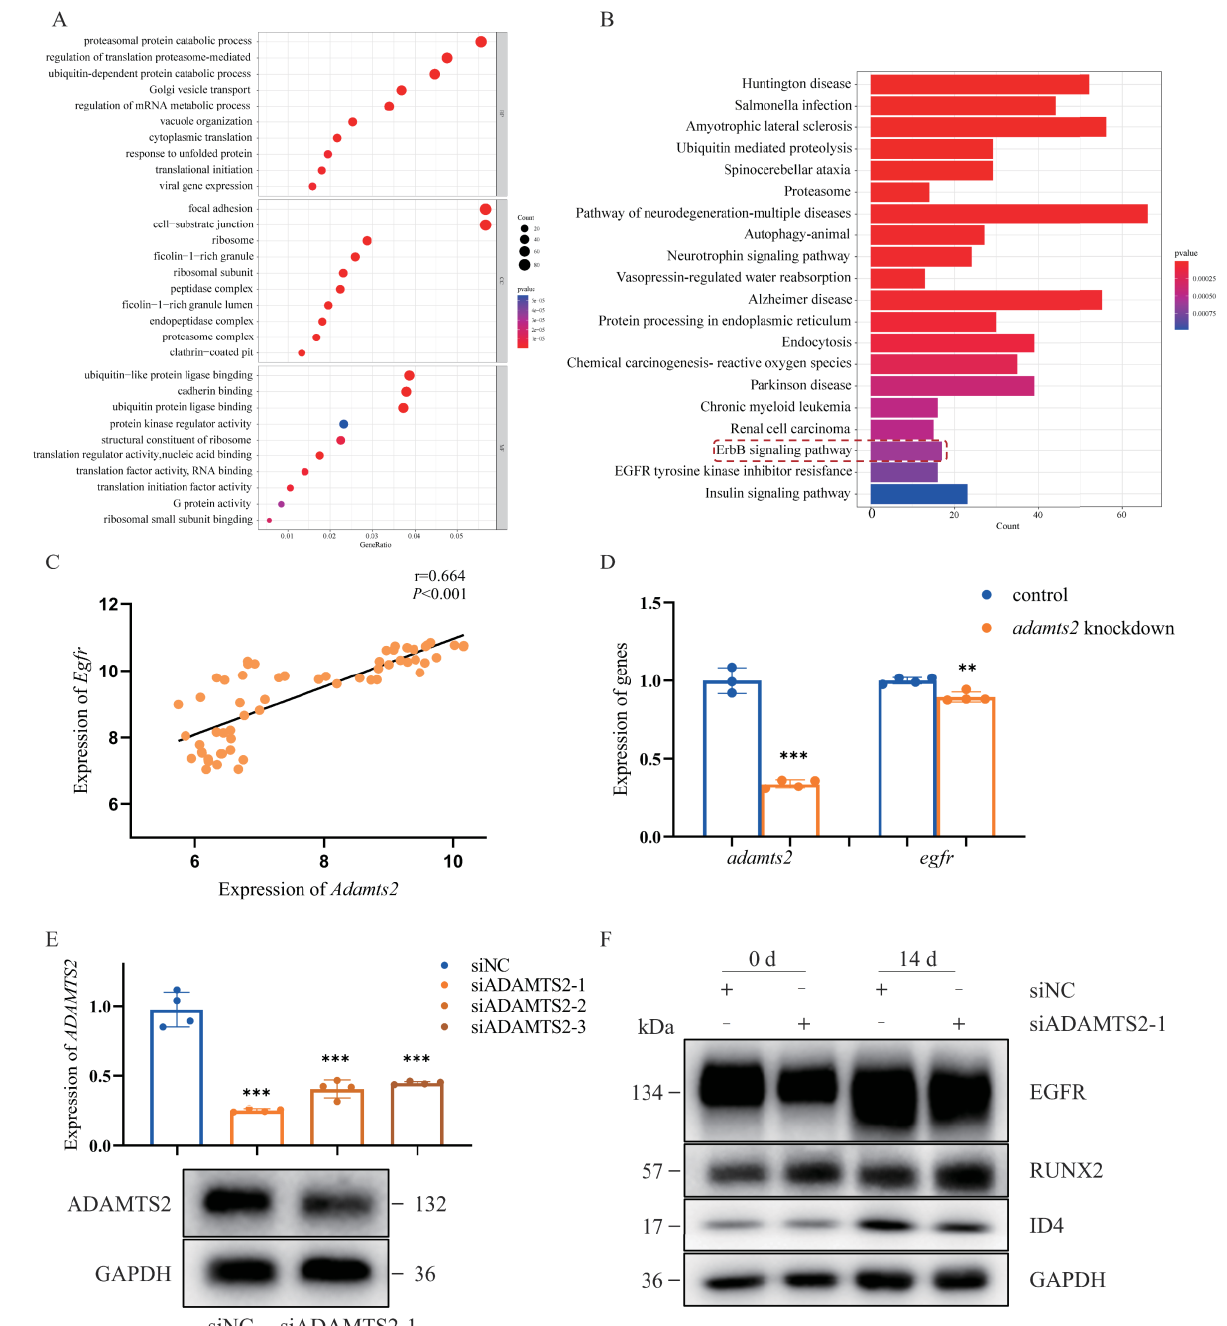
Figure 4. ADAMTS2 was involved in several important pathological pathways based on gene ontology (GO) and Kyoto Encyclopedia of Genes and Genomes (KEGG) enrichment analysis. ( A ) The top 10 GO terms by gene ratio in the biological process terms and cellular component terms and molecular function terms in the enrichment analysis. ( B ) The top 20 most significantly enriched pathways by p -value with the genes co-expressed with ADAMTS2 in the KEGG analysis. ( C ) Egfr was co-expressed with Adamts2 during mouse embryonic development of upper and lower jaw (E10.5–E14.5). ( D ) qRT-PCR analysis of the expression of egfr in the adamts2 -knockdown zebrafish embryos at 72 hpf. ( E ) qRT-PCR and Western blot analysis of the ADAMTS2 knockdown efficiency in hMSCs. ( F ) Western blot analysis of the expression of pathway key genes and osteogenic indicators in hMSCs. Bars represent group means. ** p < 0.01, *** p < 0.001. n = 4 independent replicates for all